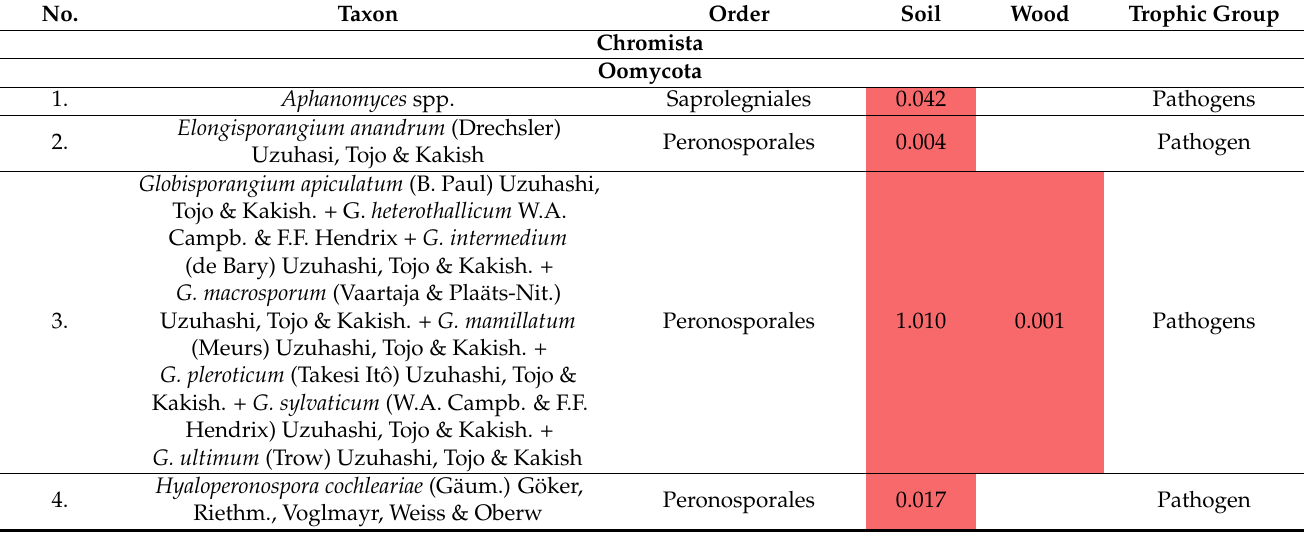
Table 1. Microbiota present in the soil and wood of the diseased